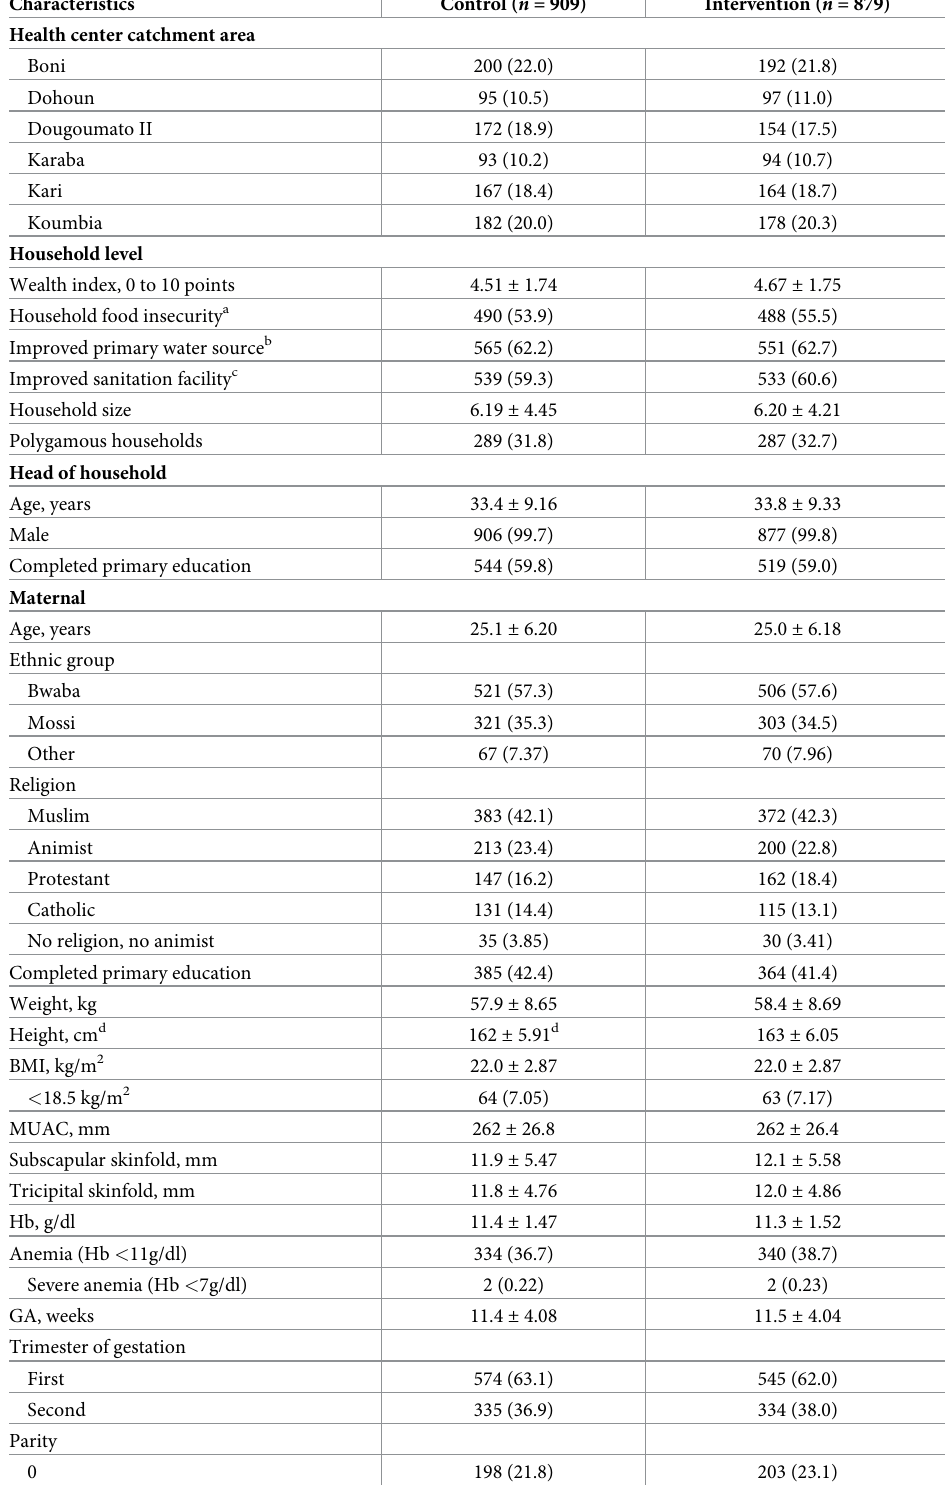
Table 2. Baseline characteristics of study